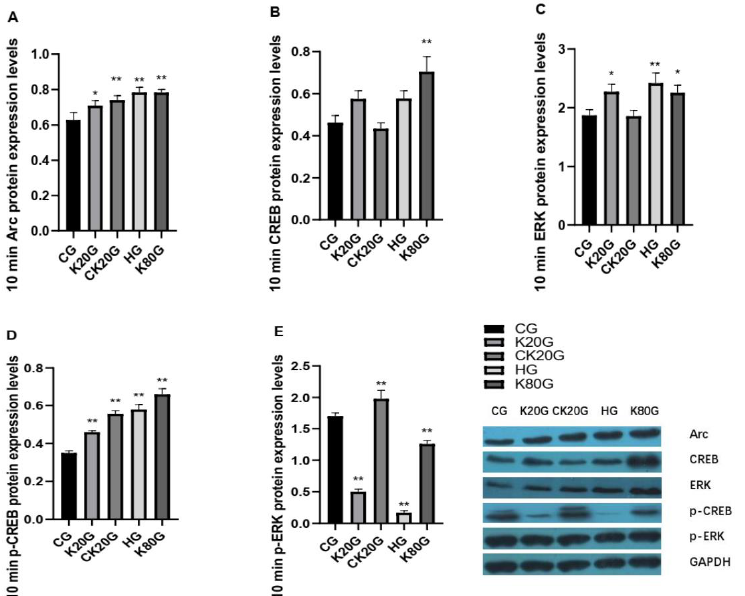
Figure 3. Expression levels of learning and memory-related proteins 10 min after ketamine injection. ( A ) The Arc protein expression levels after 10 min. ( B ) The cAMP-response element-binding protein (CREB) protein expression levels after 10 min. ( C ) The extracellular signal-regulated kinase (ERK) protein expression levels after 10 min. ( D ) The p-CREB protein expression levels after 10 min. ( E ) The p-ERK protein expression levels after 10 min. Data are expressed as means ± SD. * p < 0.05 and ** p < 0.01 versus CG.